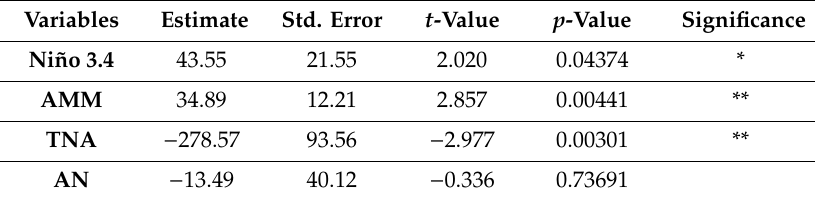
Table 2. The output of Multiple Linear Regression (MLR) model in which rainfall is a dependent variable and AMM, Niño3.4, TNA and AN are independent